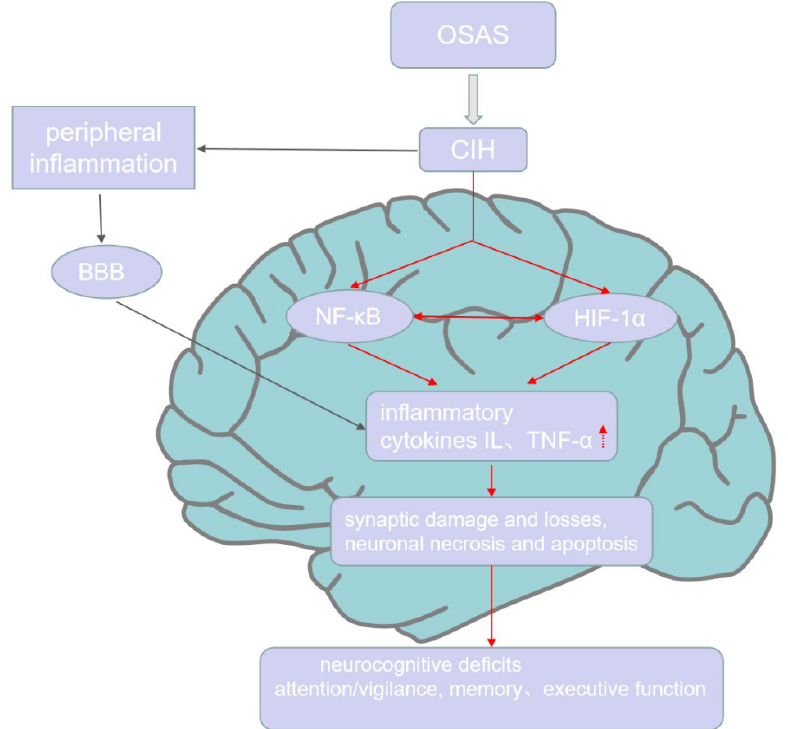
Figure 1. Inflammation and cognitive impairment in OSAS. CIH, the characteristic of OSAS, causes peripheral inflammation and access the CNS through BBB to induce the production of NF- κ B and HIF-1 α , which both promote the expression of inflammatory cytokines in the CNS. Further, HIF-1 α and NF- κ B can interact with each other. The high level of inflammation in CNS further causes neuronal necrosis, apoptosis, synaptic damage, and losses, which finally leads to neurocognitive deficits, including attention/vigilance decline, verbal–visual memory decrease, and executive dysfunction.